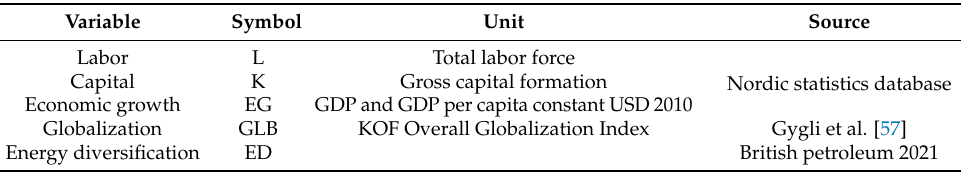
Table 1. Description of the variables.